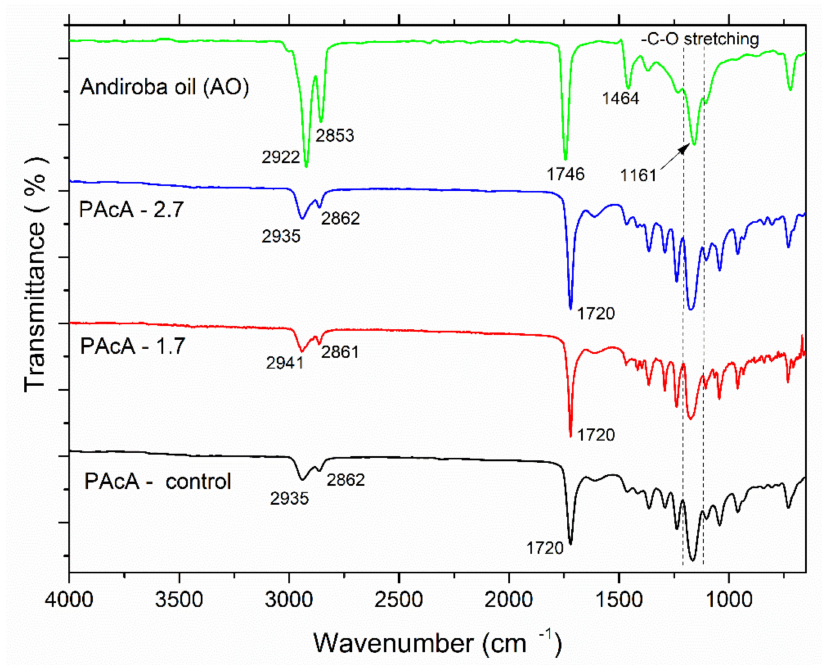
Figure 3. Fourier-transform infrared spectroscopy (FTIR) of andiroba oil and control and hybrids film of